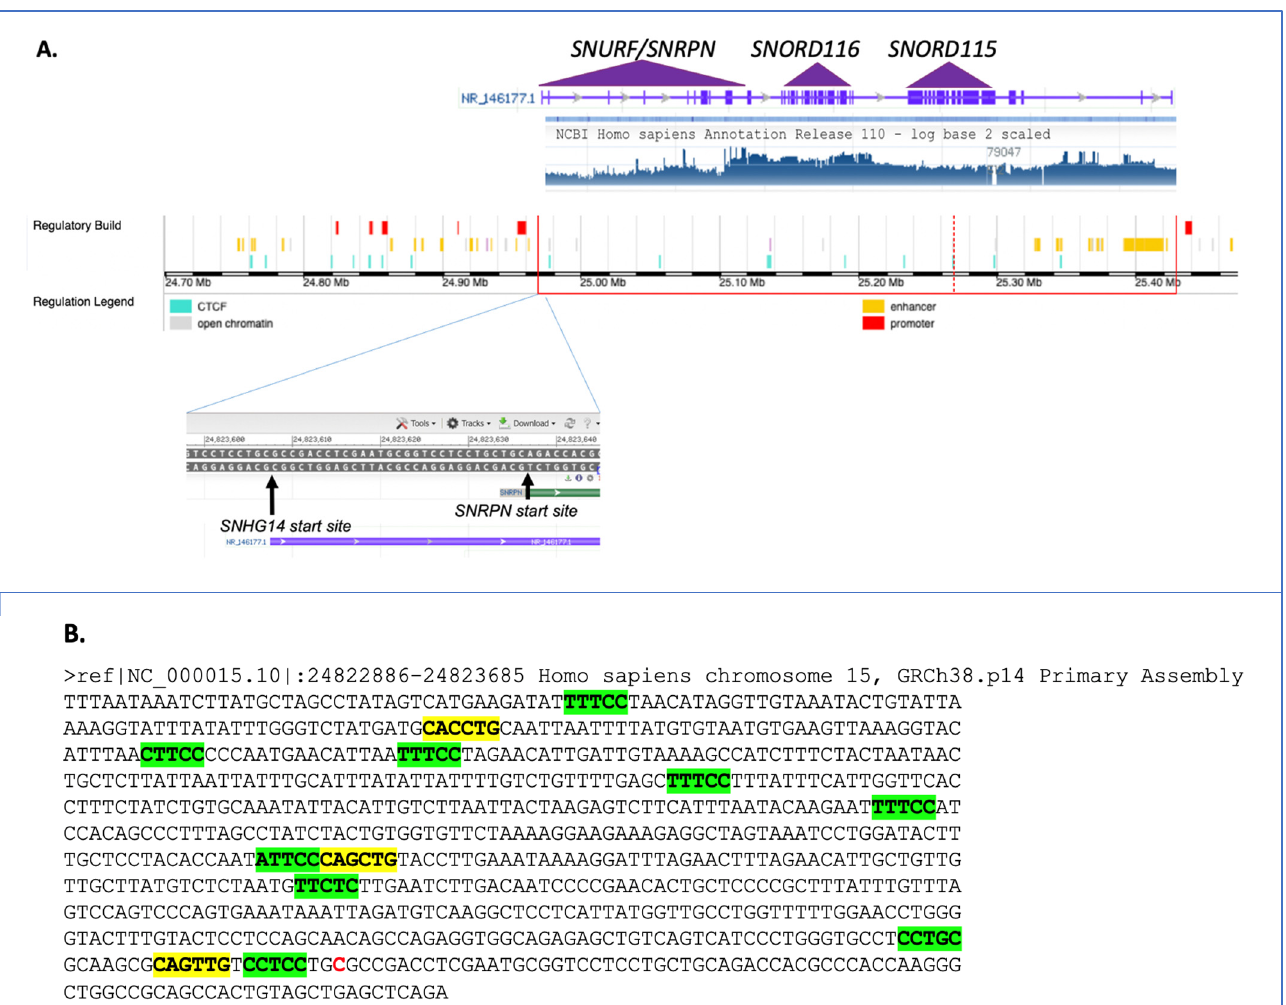
Figure 3. The promoter region of the human SNHG14 locus. ( A ) Composite figure made from the NBCI genome viewer in the region of the SNHG14 locus with the RNA-seq and regulatory tracks (top), along with a zoomed-in view of the start sites for the SNHG14 and SNRPN loci. Note the RNA-seq transcriptional activity in regions of the SNORD116 locus and SNURF / SNRPN . The UBE3A transcript region, nor the other alternative start sites, are in this view. ( B ) The nucleotide sequence surrounding the start of the SNHG14 transcript (shown as a red C residue) was downloaded and examined using the PROMO promoter transcription factor analysis site [27]. Putative p300 sites are highlighted in green. Putative basic helix-loop-helix transcription factor binding sites are highlighted in yellow.